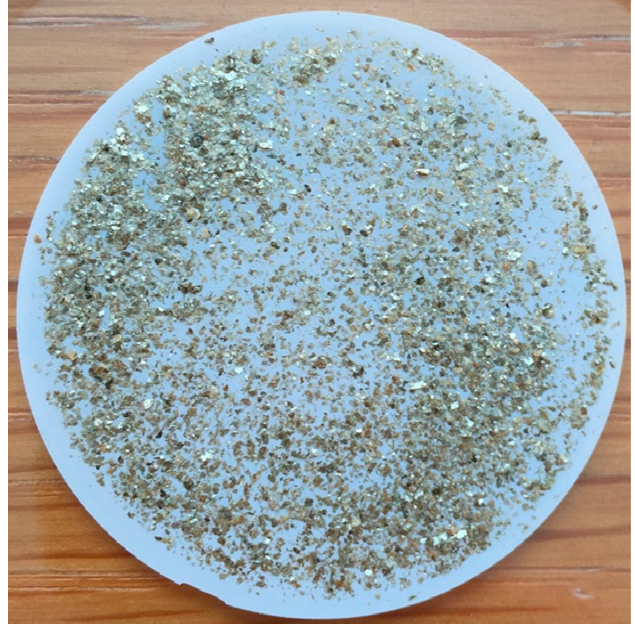
Figure 9. Buoyant particles recovered from the sample of the main hole (H) at 33 m depth in the 250–500 µ m fraction after density separation with NaI.